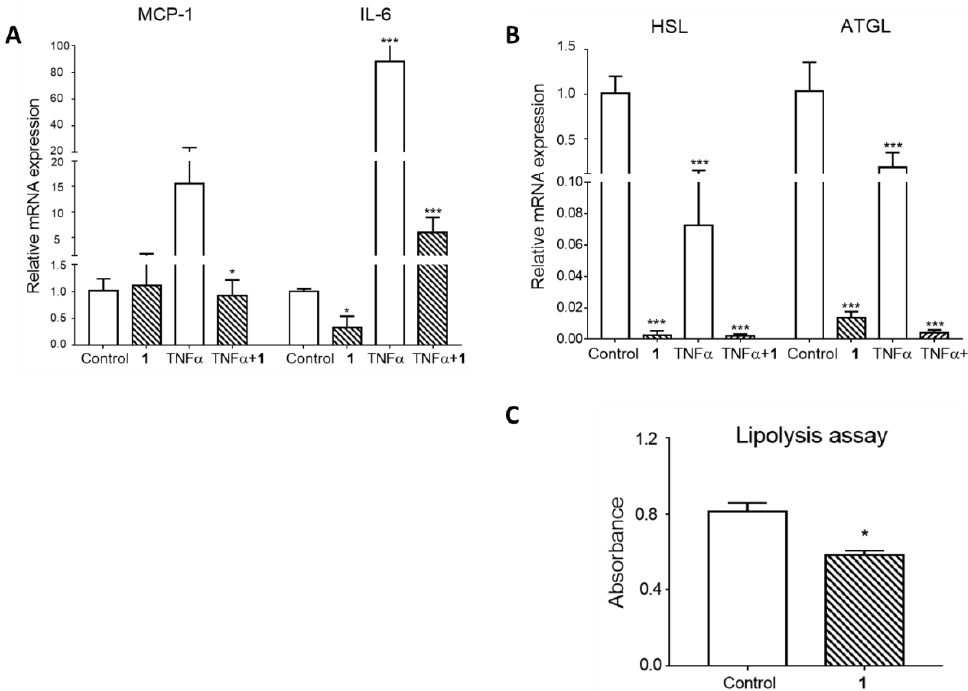
Figure 5. Effects of compound 1 on mature adipocyte gene expression and lipolysis. ( A , B ) 3T3-L1 mature adipocytes were pretreated with 100 µM of compound 1 for 1 h, followed by 10 ng/mL tumor necrosis factor α (TNF α ) treatment for 6 h. Gene expression was measured using real-time PCR. ( C ) After 24-h treatment with or without compound 1 , lipolysis was measured according to the glycerol content in the incubation medium. The values are the means ± SEM of three experiments. * p < 0.05 vs. control, *** p < 0.001 vs. control.